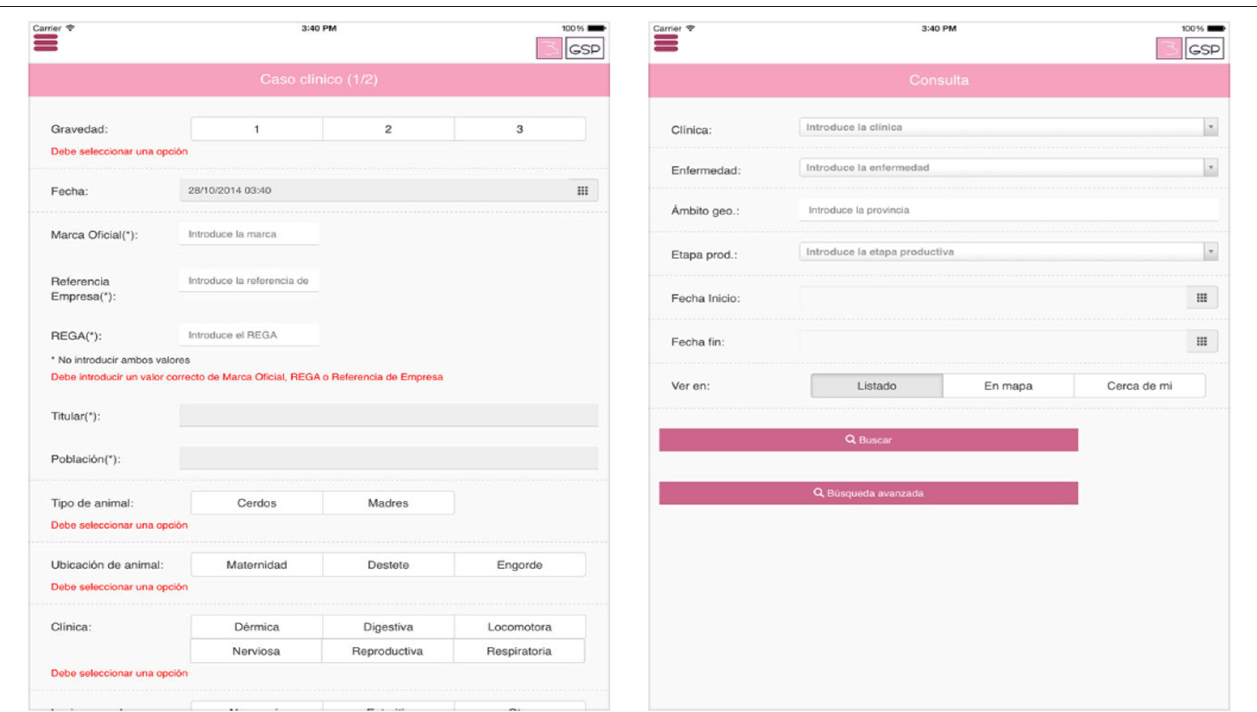
FIGURE 1 | Interface of a web application to record clinical event data from swine herds in Northeastern Spain. Fields written in Spanish. English translation: Case ( Caso clínico ), Severity ( Gravedad ), Date ( Fecha ), Regional official farm identifier ( Marca Oficial ). Company reference ( Referencia empresa ), National official farm identifier ( REGA ), Owner ( Titular ), Municipality ( Población ), Type of animal ( Tipo de animal ), Piglets or fattening pigs ( Cerdos ), Sows ( Madres ), Farm Location of the affected animals within the farm ( Ubicación del animal ), Maternity ( Maternidad ), Nursery ( Destete ), Fattening ( Engorde ), Clinical signs (C línica ), Dermatological ( Dermatológica ), Digestive ( Digestiva ), Locomotor ( Locomotora ), Neurological ( Nerviosa ), Reproductive ( Reproductiva ), Respiratory ( Respiratoria ), Presumptive disease ( Enfermedad ), Geographical situation ( Ámbito geográfico ), Productive phase ( Etapa productiva ), Date of clinical onset ( Fecha inicio ), Date of clinical end ( Fecha fin ), See ( Ver en ), List ( Listado ), Map representation ( En mapa ), Closest clinical cases ( Cerca de mí ), Search ( Buscar ), Advanced search ( Búsqueda avanzada